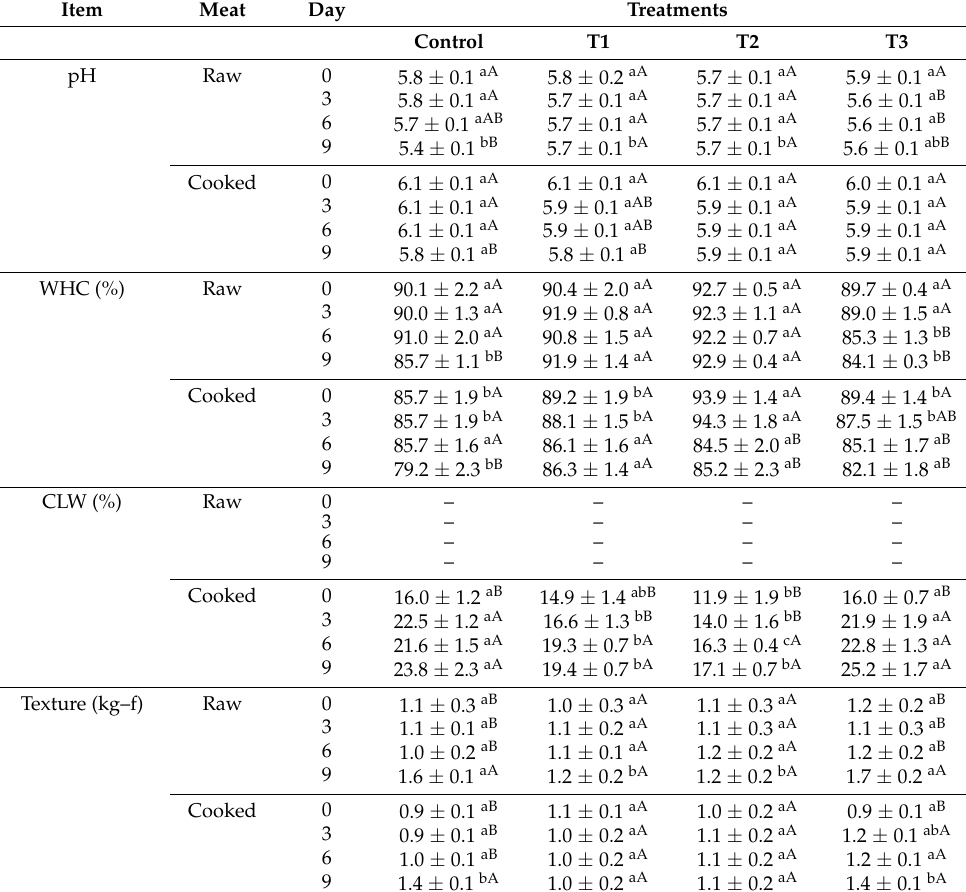
Table 3. Meat quality attributes of raw and cooked pork patties during storage